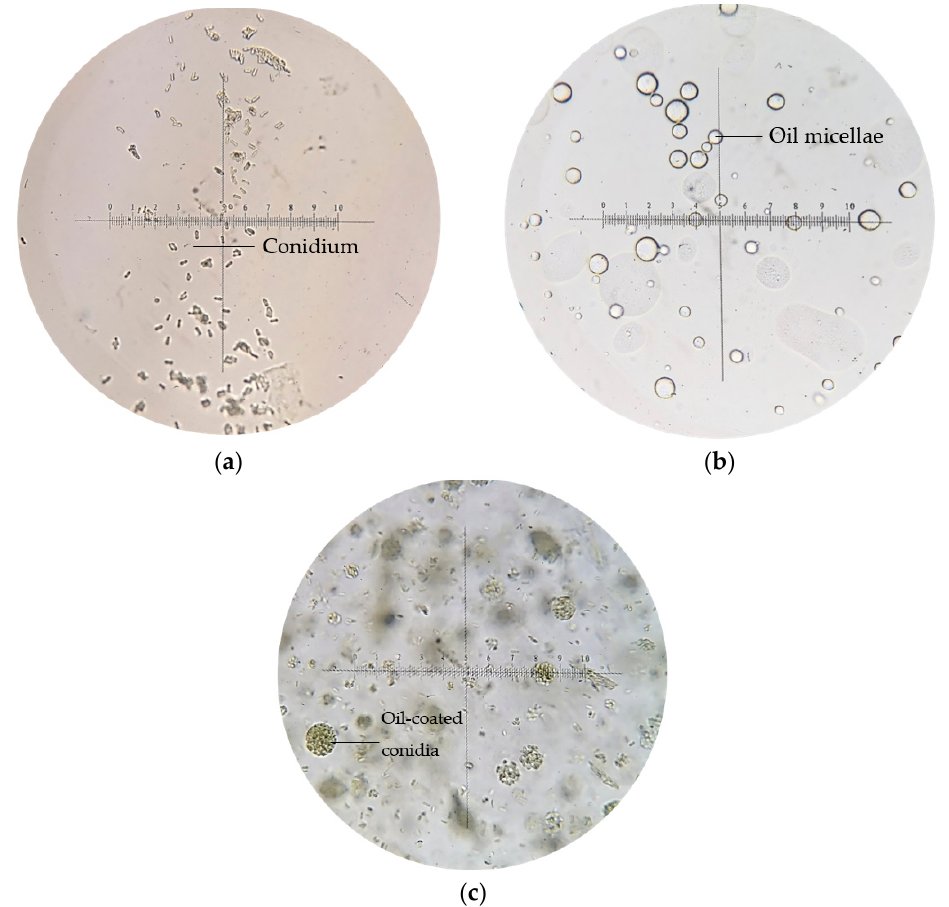
Figure 5. Microscopic images of ( a ) conidia suspension in water, ( b ) emulsion blank, and ( c ) emul- sion-formulated conidia, at 400× magnification.